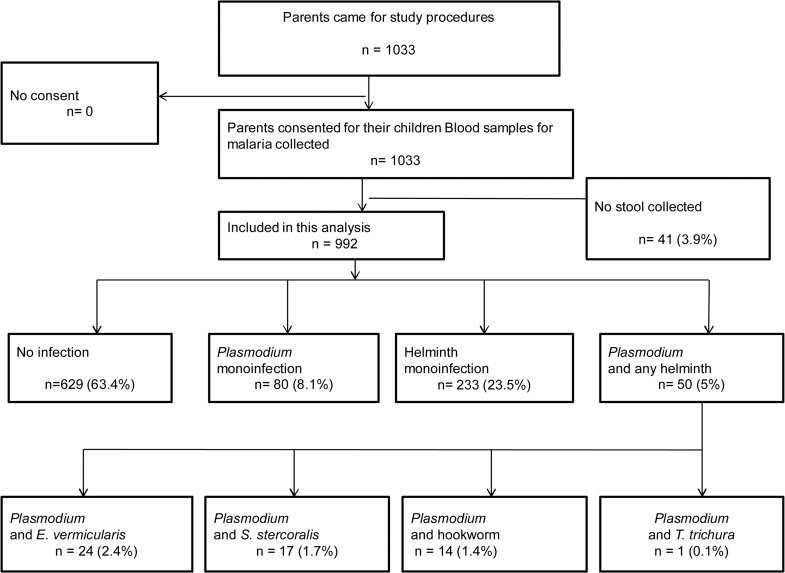
Flow of study participants and prevalence of Plasmodium and helminth infections.